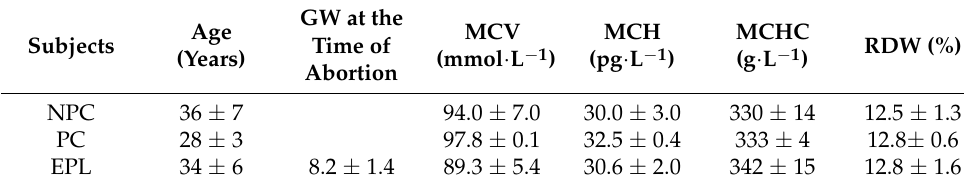
Table 1. RBCs indices: mean corpuscular volume (MCV), mean corpuscular hemoglobin (MCH), mean corpuscular hemoglobin concentration (MCHC), and red cell distribution width (RDW); age (mean and SD) of nonpregnant controls (NPC), pregnant controls (PC), and women with early pregnancy loss (EPL) and the gestational weeks (GW) of women with EPL.